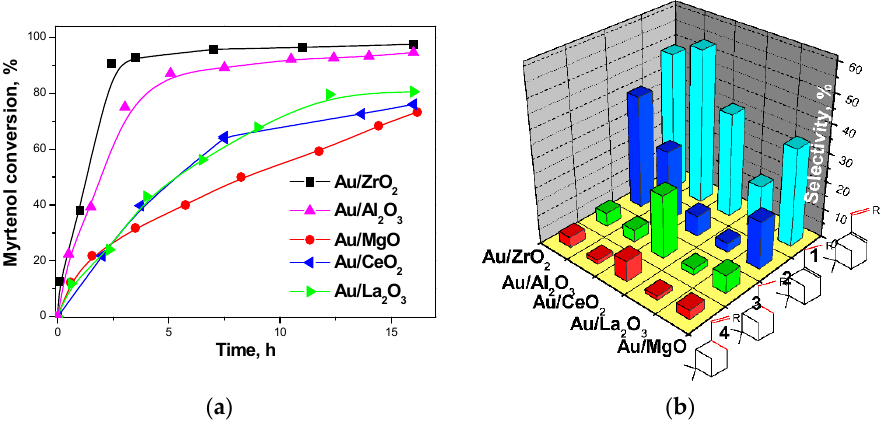
Figure 24. Myrtenol conversion ( a ) and the selectivity ( b ) to the corresponding products 1 (blue bars), 2 (dark blue bars), 3 (green bars), and 4 (red bars) at the same myrtenol conversion (74%) for myrtenol amination in the presence of gold supported on ZrO 2 , Al 2 O 3 , CeO 2 , La 2 O 3, and MgO. The reaction conditions: T = 180 °C, p(N 2 ) = 9 bar, myrtenol 1 mmol, aniline 1 mmol, toluene 10 mL, catalyst 1.4